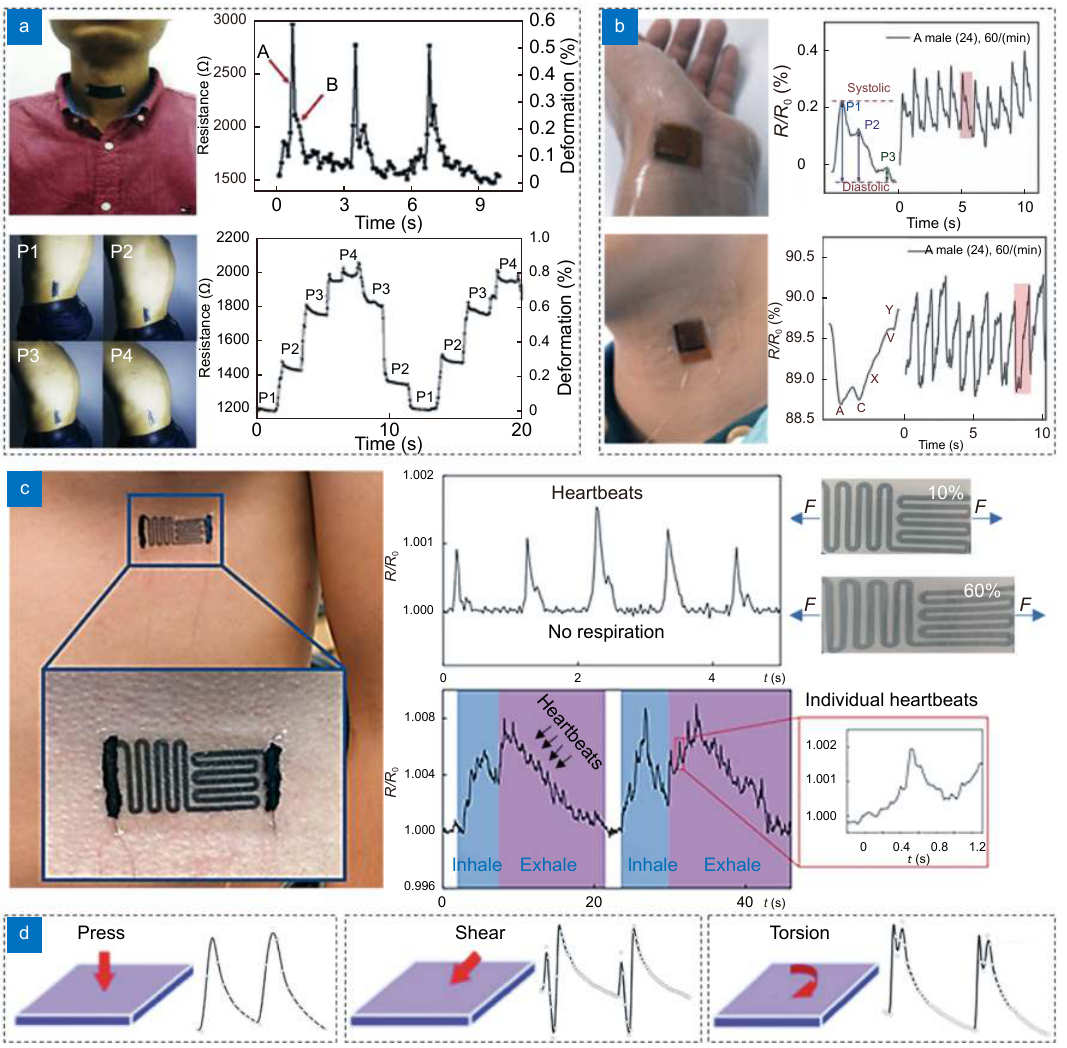
Fig. 10 | Piezoresistive sensor for health monitoring. ( a ) Detection of physical activities by piezoresistive sensor, including the swallowing (A and B: the pharyngeal and esophageal phase, respectively) and the posture of human back 152 . ( b ) Detection of physiological activities (e.g. wrist and jugular venous pulse) at high sensitivities 153 . ( c ) Detection of myocardic activities (e.g. heartbeats at breathing and not breathing) by a piezoresistive sensor 154 . ( d ) Identification of different mechanical stimuli, including pressure, shear and torsion force 132 . Figure reproduced with permission from: (a) ref. 152 , (d) ref. 132 , Elsevier; (b) ref. 153 , (c) ref. 154 , American Chemical